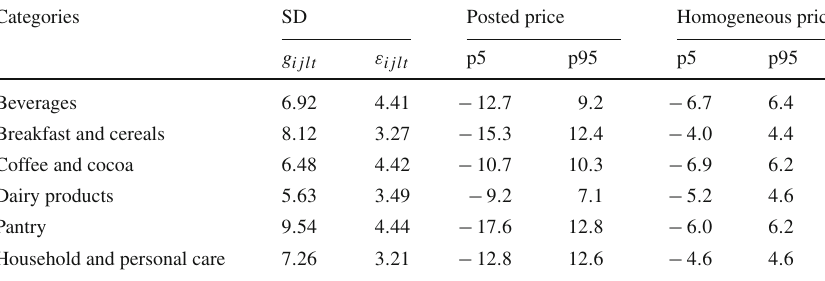
Table 1 Moments of the price dispersion distribution (by